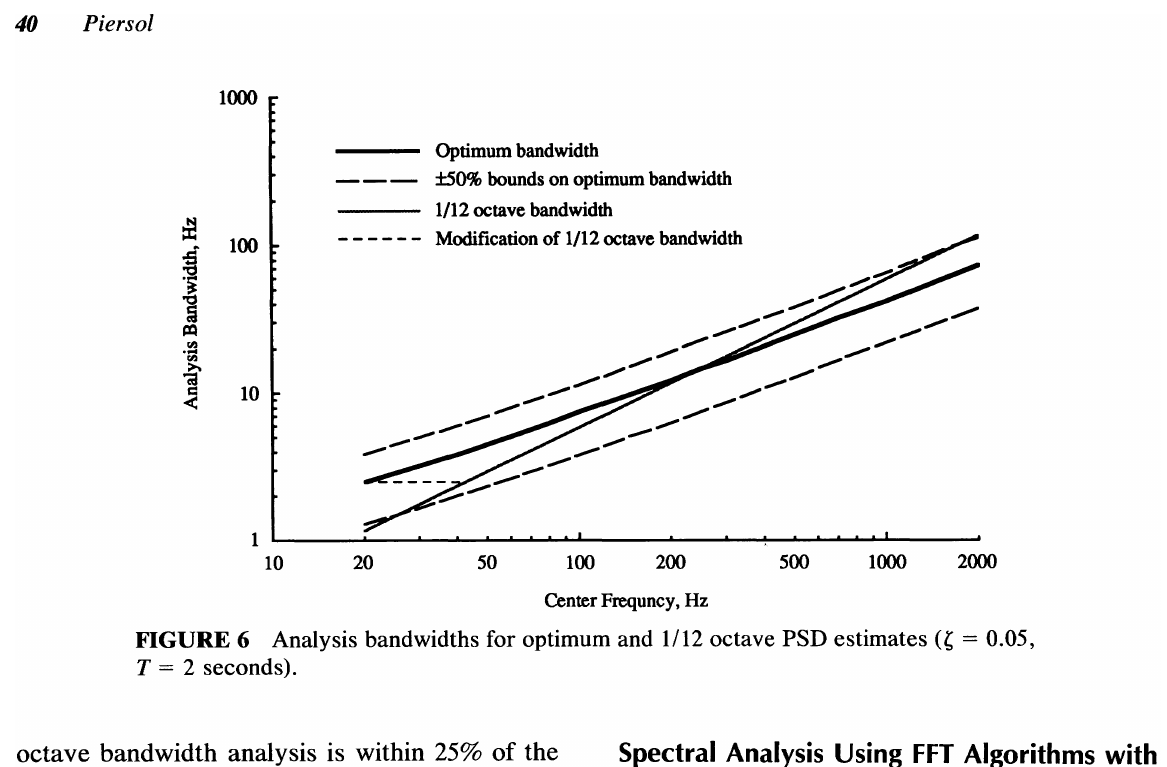
FIGURE 6 Analysis bandwidths for optimum and 1112 octave PSD estimates (' = 0.05, T = 2 seconds).